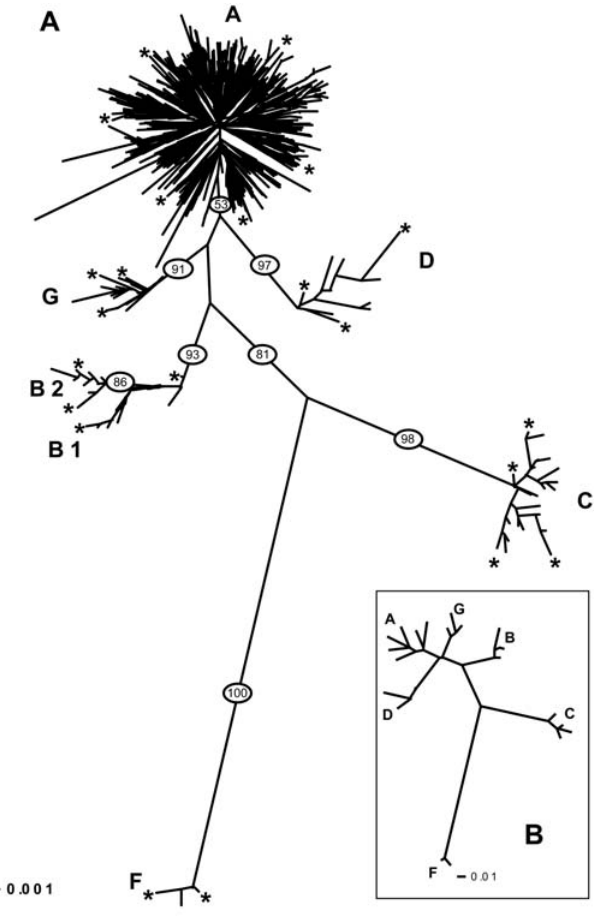
Figure 1. Neighbor-joining trees of domestic goat based on 1540 mtDNA haplotypes (A) and on the 22 reference mtDNA haplotypes (B). Distances were calculated using the Kimura 2-Parameter model with gamma correction (alpha=0.28). On the (A) tree, the numbers on the branches represent bootstrap values out of 1000 replications, and the stars point out the position of reference individuals for each haplogroup used to construct the (B) tree (see Table 5).